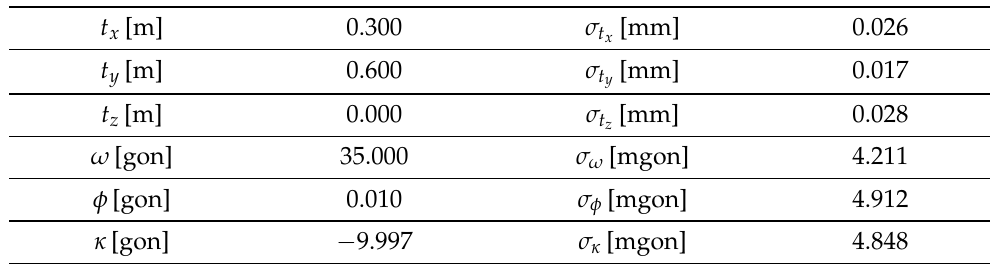
Table 5. Results of the estimated rigid body movement after having extended S CS (data set V15, a = 0, n CS = 25, n CS , ex = 45)